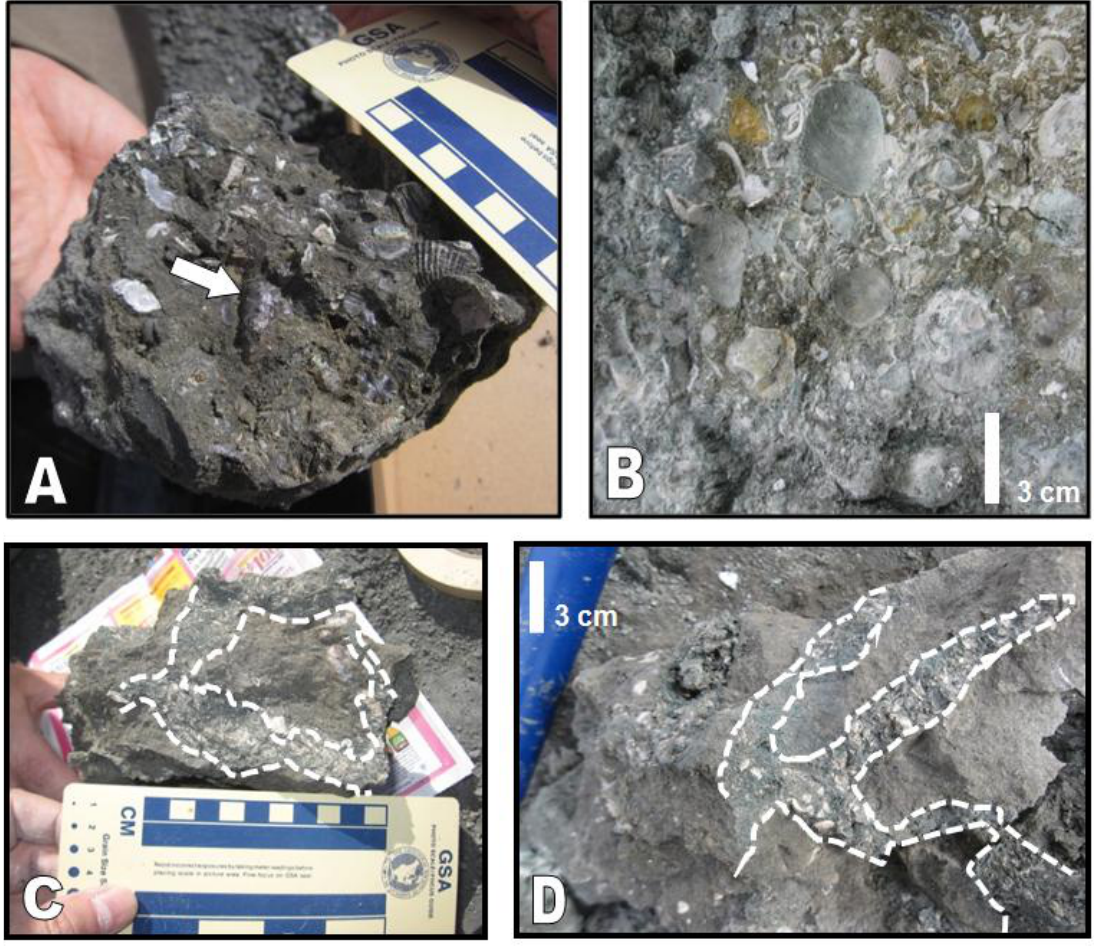
Figure 3. Sediment samples from our collecting site. ( A ) Fossiliferous Owl Creek fragment containing bivalves, gastropods and cephalopods within a muddy matrix. The fragment contains the index late Maastrichtian scaphite Discoscaphites iris (white arrow). ( B ) Coquinite forming the basal layer of the Clayton Formation showing the characteristic lithology and concentrated shell hash. ( C ) and ( D ) Fragments from the Owl Creek Formation contain burrows (outlined in white) of the ichnofossil Thalassinoides that progress downward from the Clayton Formation into the Owl Creek Formation. The burrows are filled with shell fragments and Clayton